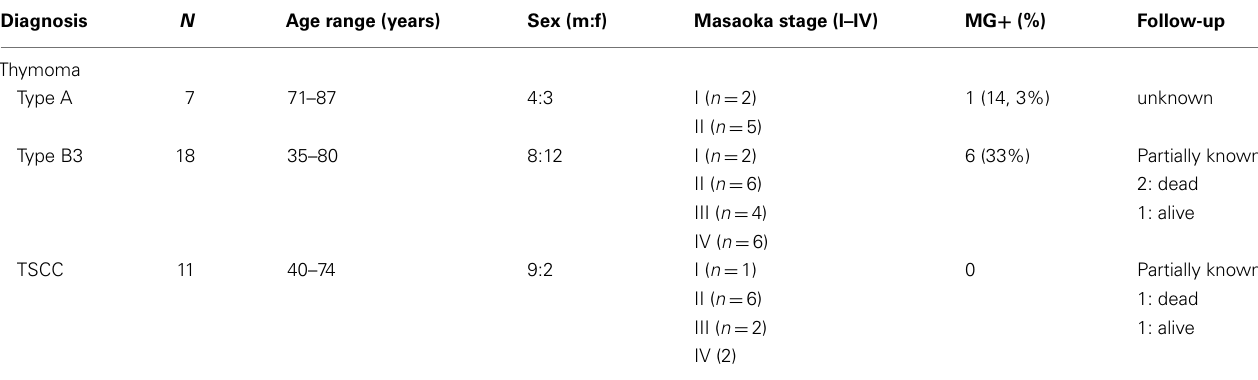
Table 2 | Characteristics of 36 recentWHO typeA and B3 thymomas andTSCCs that served as validation set for cases fromTable